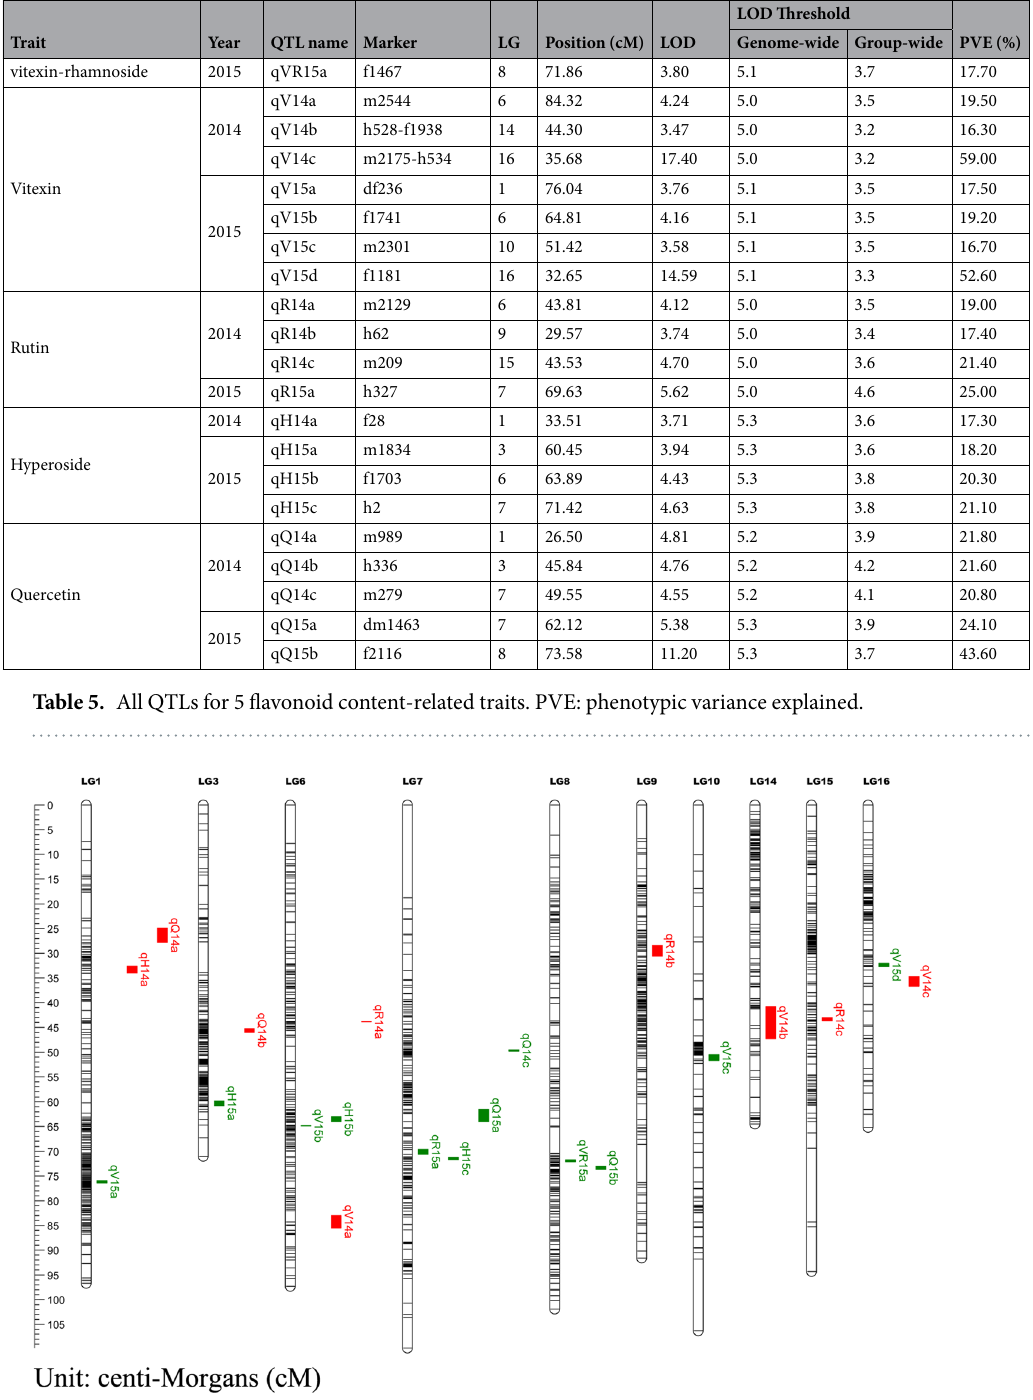
Figure 8. Genomic QTL distribution on 10 different